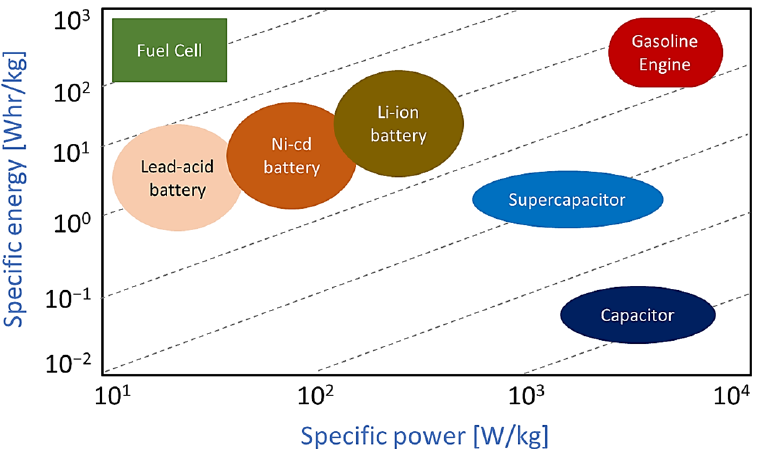
Figure 2. The specific power/energy of electrochemical sources.